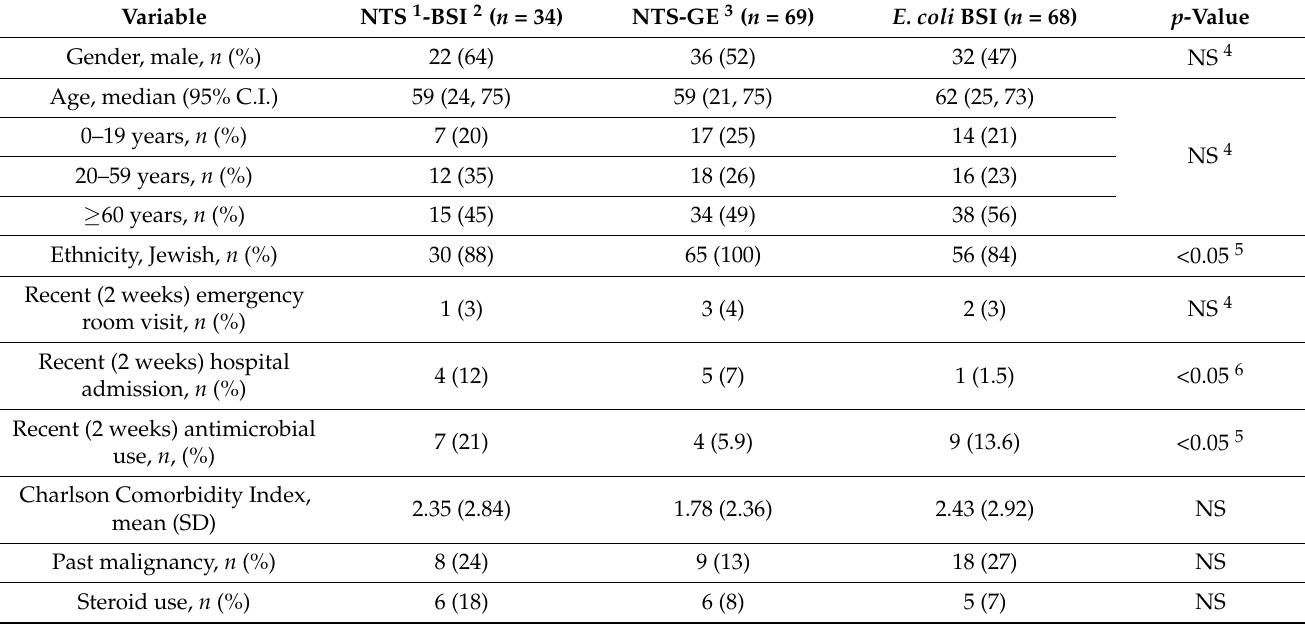
Table 1. Demographic and medical characteristics of patients in all three